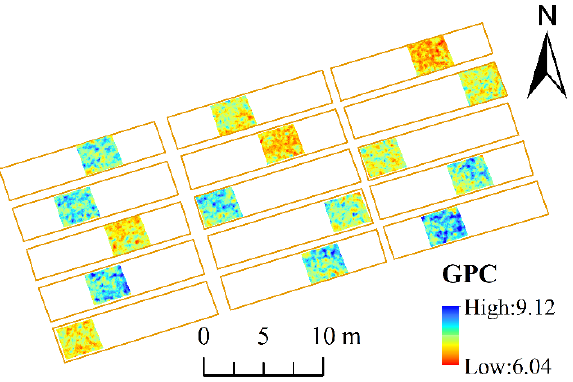
Figure 15. Grain protein content (GPC) regression model based on the three-dimensional monitoring index of rice variety V1 (Meixiangzhan 2) for the panicle initiation stage in 2019.